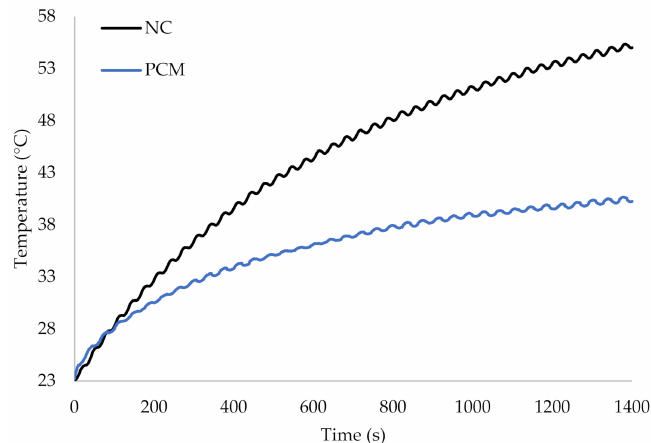
Figure 4. Temperature evolution of the LiC cell under 150 A current rate when the pure paraffin PCM is used as the cooling system. Natural convection (NC) is shown as well for comparison.